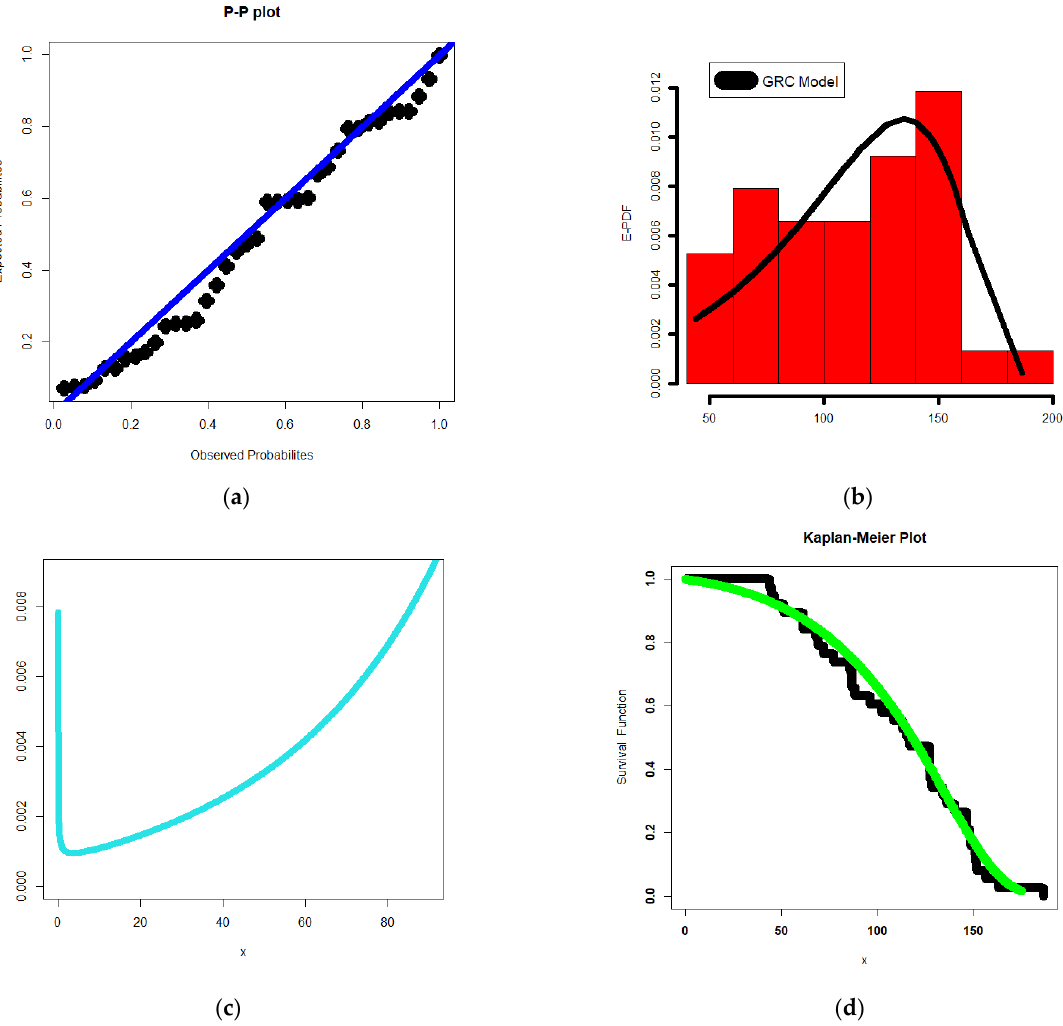
Figure 7. The P – P ( a ); E-PDF ( b ); E-HRF ( c ) Kaplan – Meier plot ( d ); for the minimum flow data. Figure 7. The P–P ( a ); E-PDF ( b ); E-HRF ( c ) Kaplan–Meier plot ( d ); for the minimum flow